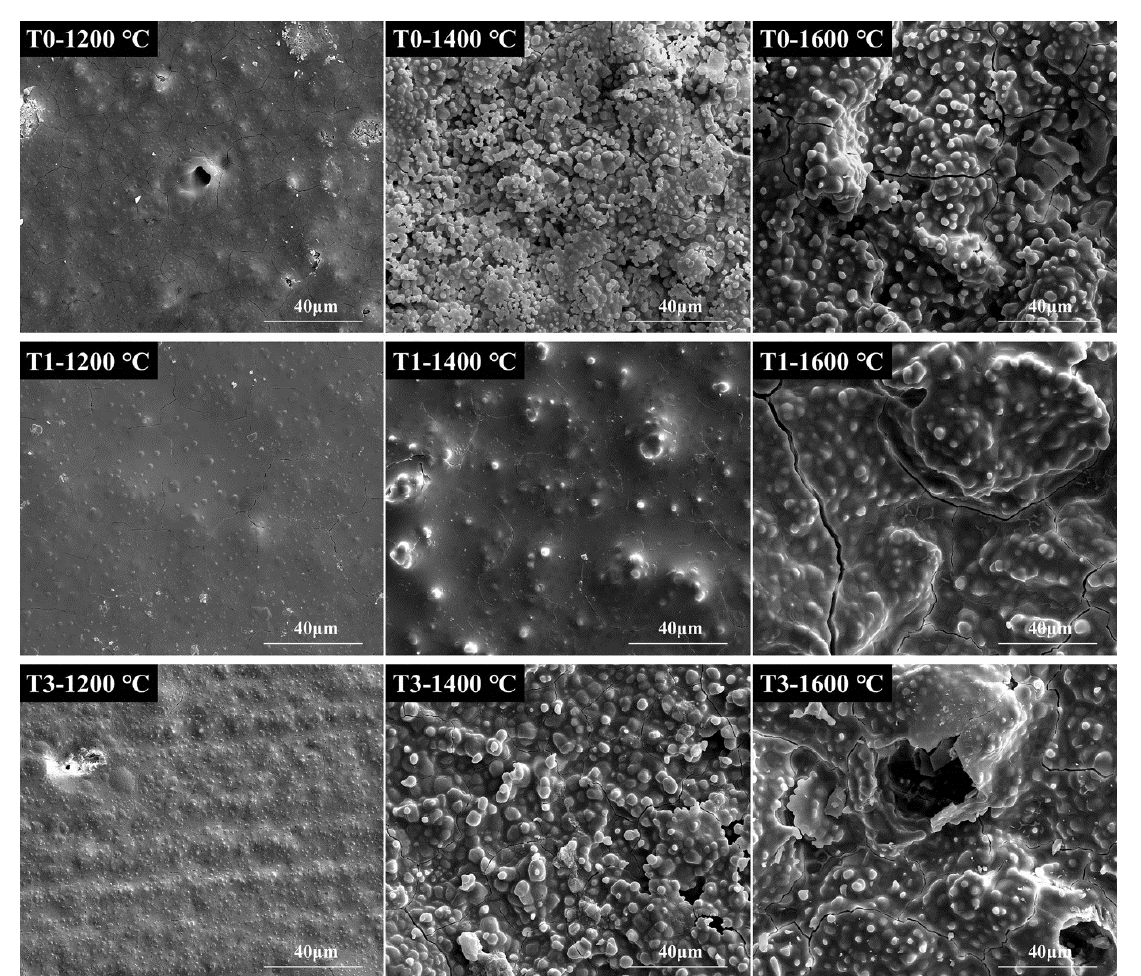
Fig. 11 SEM microstructures of Si 2 BC 3 N ceramics after oxidation